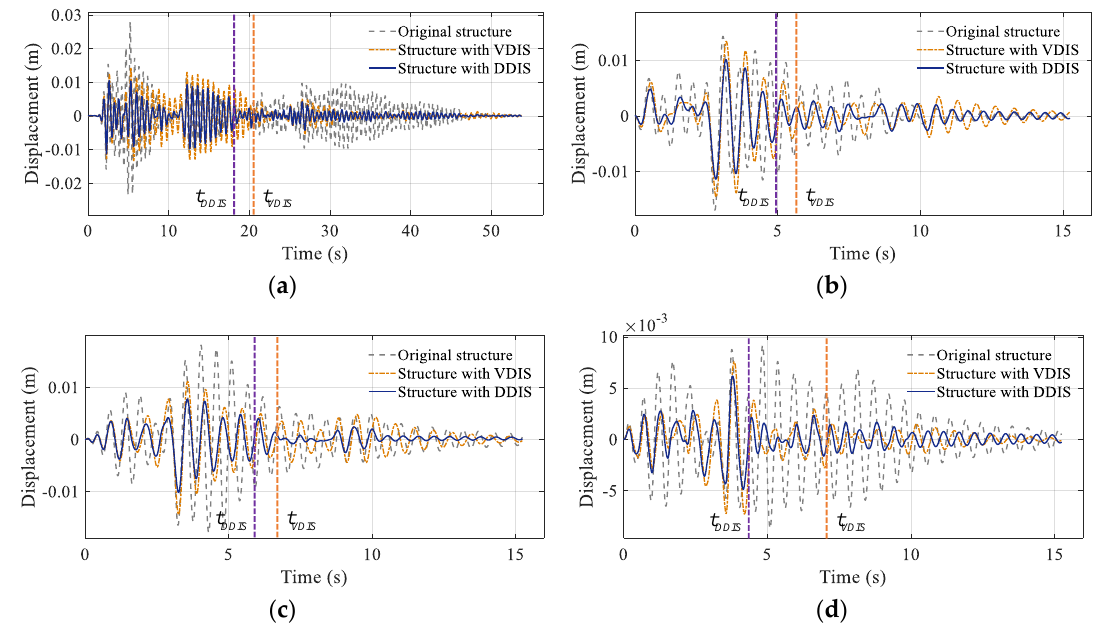
Figure 13. Displacement responses of the structures with the DDIS and velocity-dependent damping inerter system (VDIS) under ( a ) El Centro, ( b ) low-frequency seismic (LS) excitation, ( c ) severest seismic (SS) excitation, and ( d ) high-frequency seismic (HS) excitation.